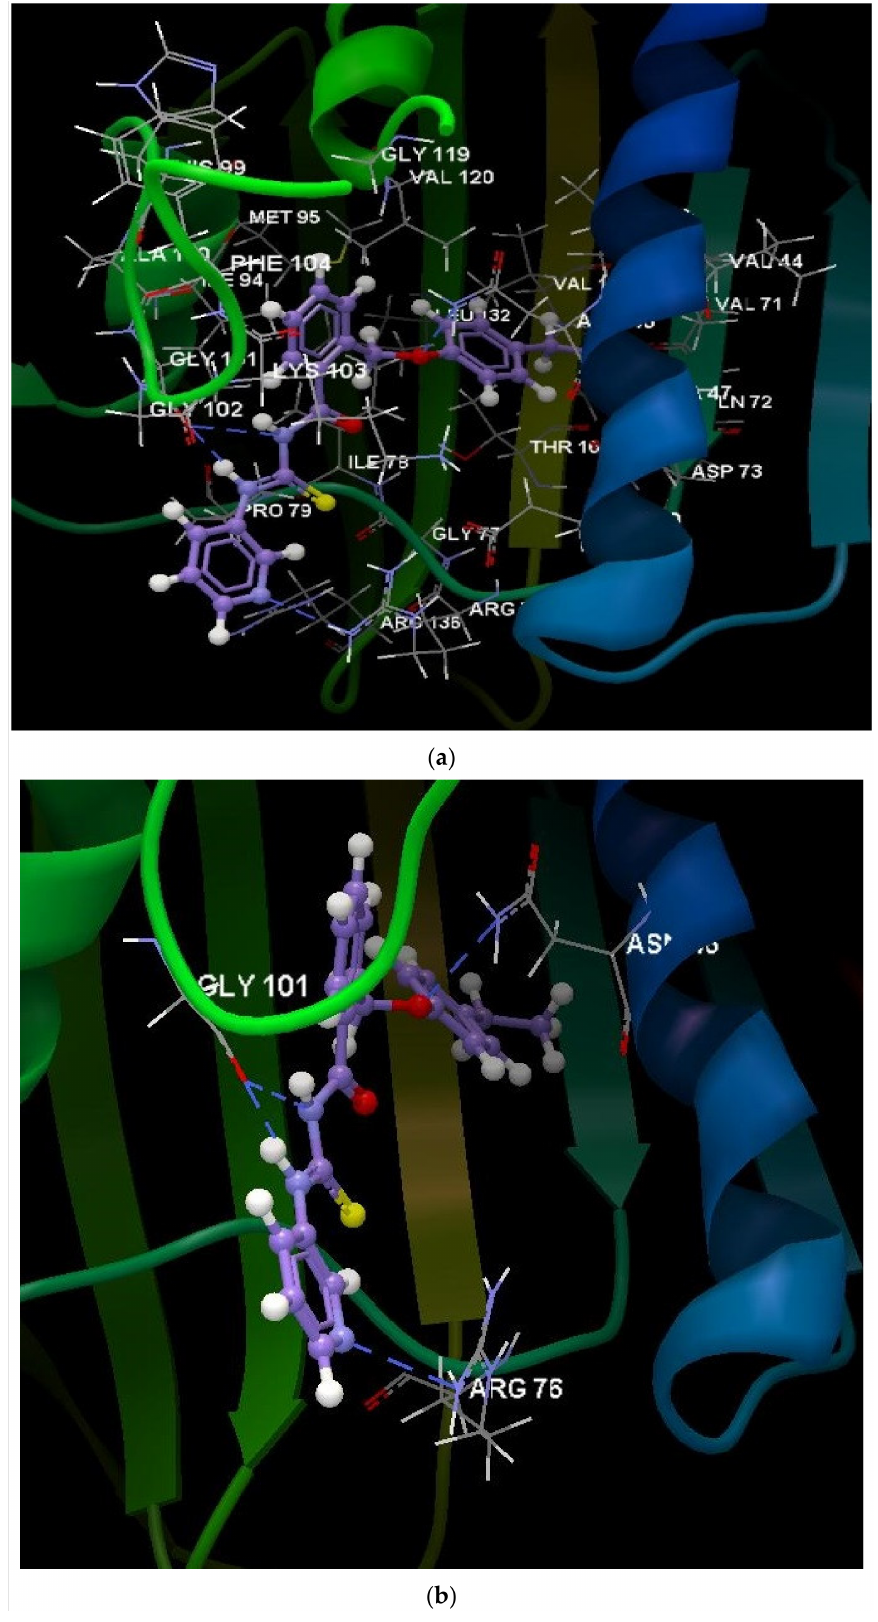
Figure 9. ( a ) Interaction group of the ligand 1c. ( b ) Hydrogen bonds created between the ligand 1c and the amino acids ASN 46, GLY 101, and ARG